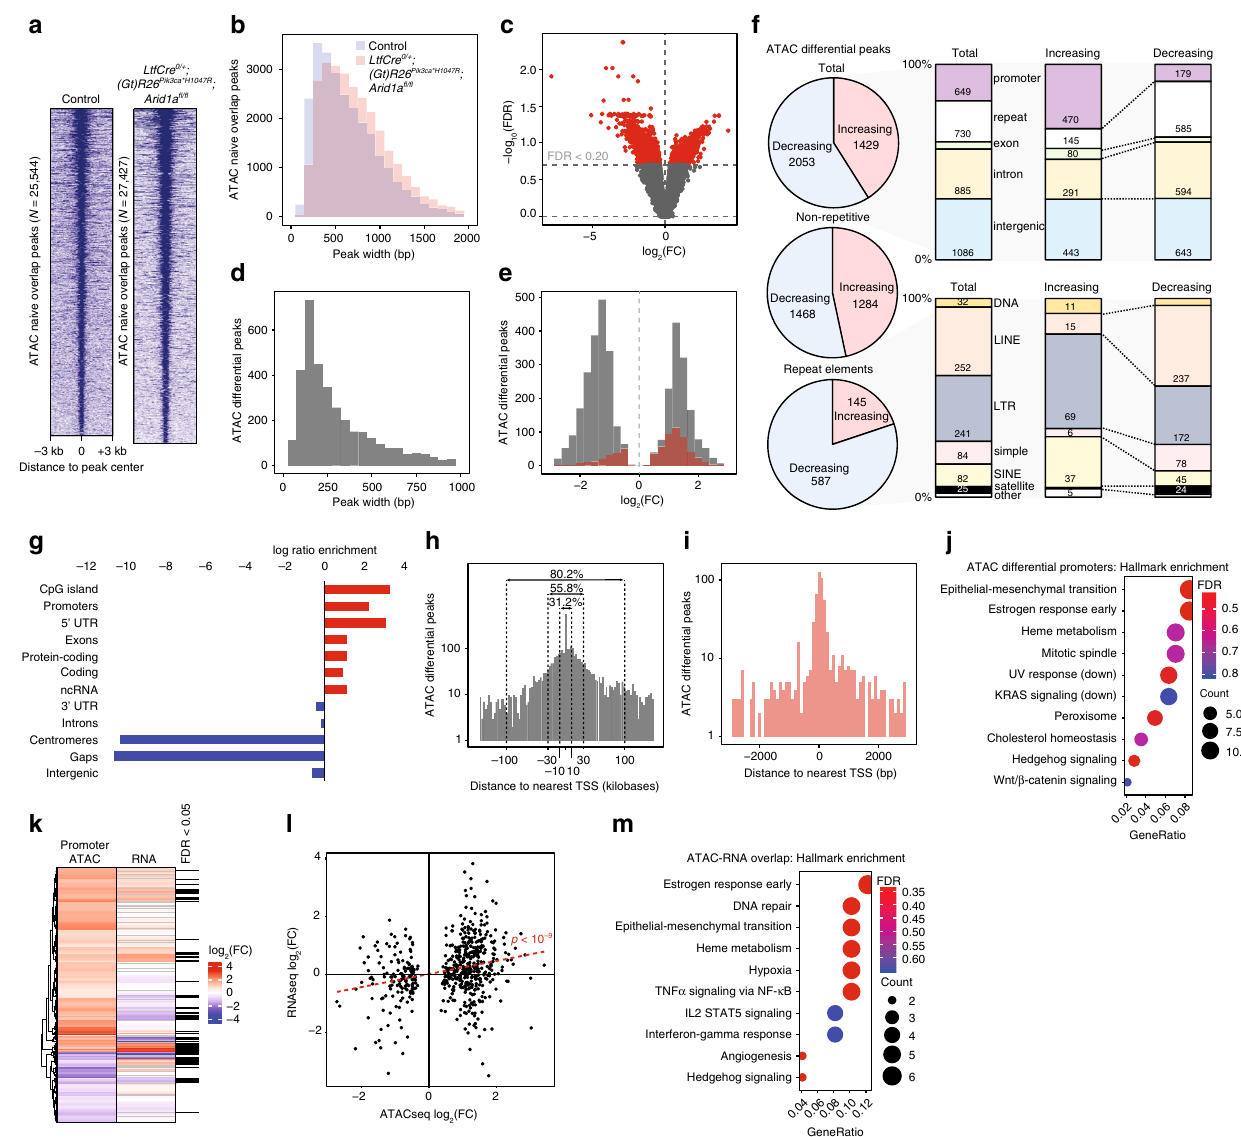
Fig. 4 ATAC-seq analysis of differentially accessible chromatin in LtfCre 0/ + ; (Gt)R26Pik3ca *H1047R ; Arid1a fl / fl endometrial epithelium. a ATAC-seq read density heatmap from naive overlapping peaks of control and LtfCre 0/ + ; (Gt)R26Pik3ca *H1047R ; Arid1a fl / fl EPCAM-positive cells, ranked by total intensity. Reads are centered on the middle of the accessible peak ±3 kb. Control ( N = 2, pooled groups of six mice) and LtfCre 0/ + ; (Gt)R26Pik3ca *H1047R ; Arid1a fl / fl ( N = 2, single mice). b Peak width distributions of control and LtfCre 0/ + ; (Gt)R26Pik3ca *H1047R ; Arid1a fl / fl ATAC-seq peaks, which are signi fi cantly different ( p < 10 − 15 , unpaired Mann – Whitney U , two-tailed). c Volcano plot for differential accessibility of ATAC-seq peaks between control and LtfCre 0/ + ; (Gt) R26Pik3ca *H1047R ; Arid1a fl / fl cells. Red points represent signi fi cant peaks (FDR < 0.20). d Peak width distribution of differentially accessible peaks. e Magnitude distribution of differentially accessible peaks separated by total peaks (gray) and promoter peaks (red, within 3 kb of TSS). f Detailed peak annotation of increasing and decreasing differentially accessible regions for total, non-repetitive and repetitive peaks based on genome annotation. g Enrichment for signi fi cant genomic features among differentially accessible peaks, ranked by p -value. Enrichment ratio is calculated by bp of feature in ATAC peak set compared to background genome. h Histogram of all differential ATAC peaks depicting distance to nearest TSS. Percent of peaks found within + / − 10, 30, or 100 kb of the TSS are shown. i Histogram of differential ATAC promoter peaks depicting distance to nearest TSS. j mSigDb Hallmark pathway enrichment of genes with differentially accessible promoter peaks. k Differentially accessible promoter peak clustering based on direction and magnitude of change in gene expression and promoter accessibility. Black bars indicate signi fi cant differential gene expression by RNA-seq (FDR < 0.05). l Scatter plot depicting the relationship between direction and magnitude of change in accessibility and gene expression for differential promoter peaks. Accessibility and expression were signi fi cantly correlated ( r s = 0.26, p < 10 − 9 , Spearman). m mSigDb Hallmark pathway enrichment of